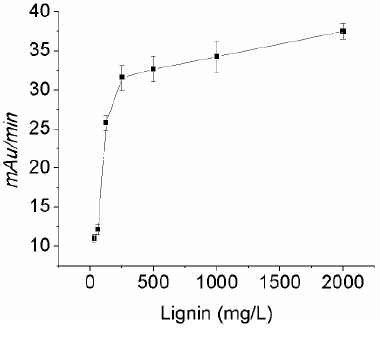
Figure 4. The steady-state activity of Pf DyP B2 with Kraft lignin as monitored by absorbance change at 465 nm [27,28].